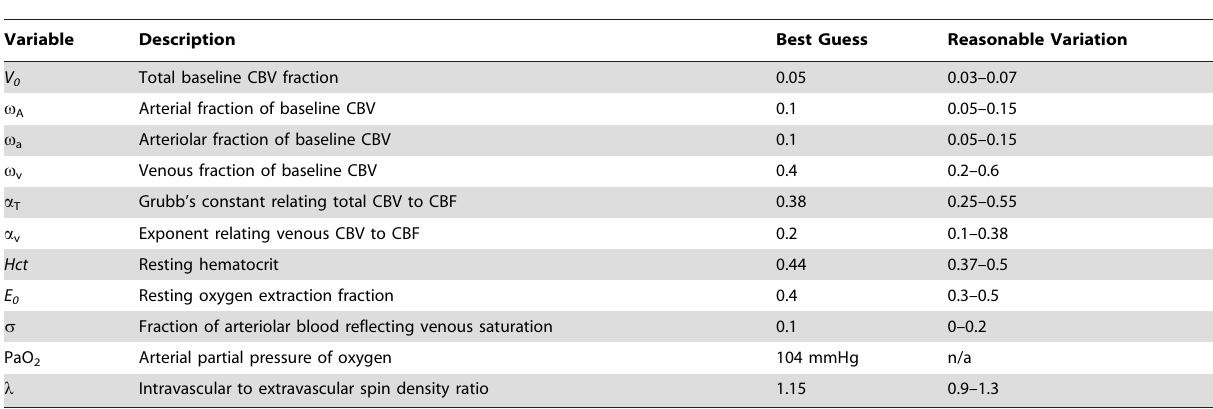
Table 1. Input parameters to the detailed model.